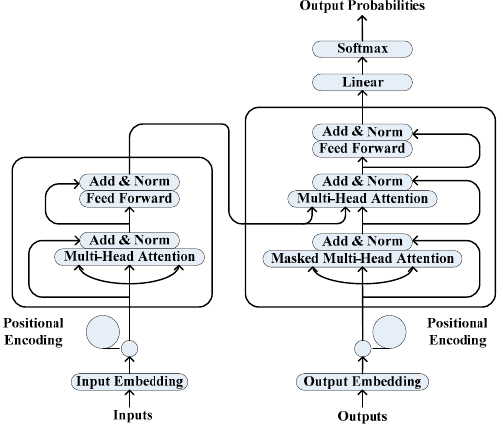
Figure 1. The structure of the single-source Transformer model with the encoder–decoder